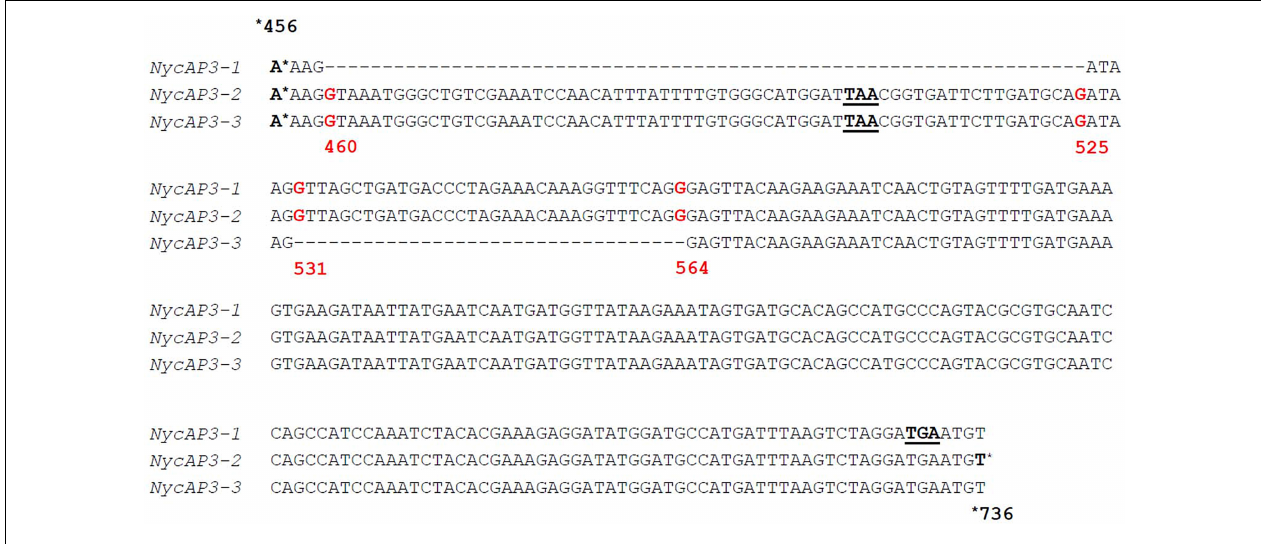
Frontiers in Plant Science |